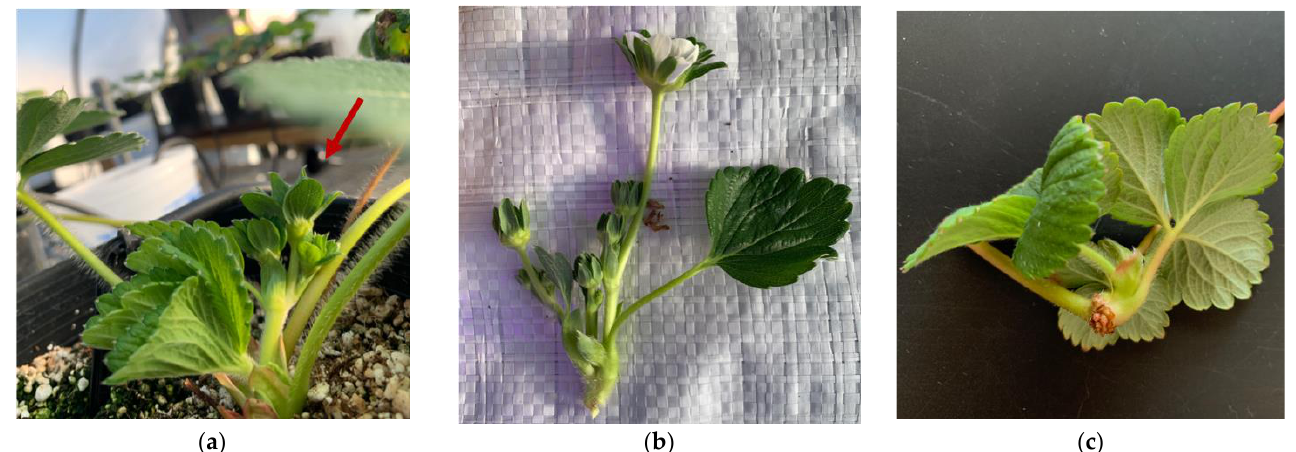
Figure 1. The inflorescence structure and daughter plant of strawberry plant ‘Albion’. ( a ) An inflorescence to be counted with visible stalk and flower bud. The arrow points to the flower bud. ( b ) An inflorescence to be removed with visible primary flower and elongated stalk. ( c ) A strawberry (‘Albion’) daughter plant (runner tip) with three fully expanded leaves and visible rootlets [3].